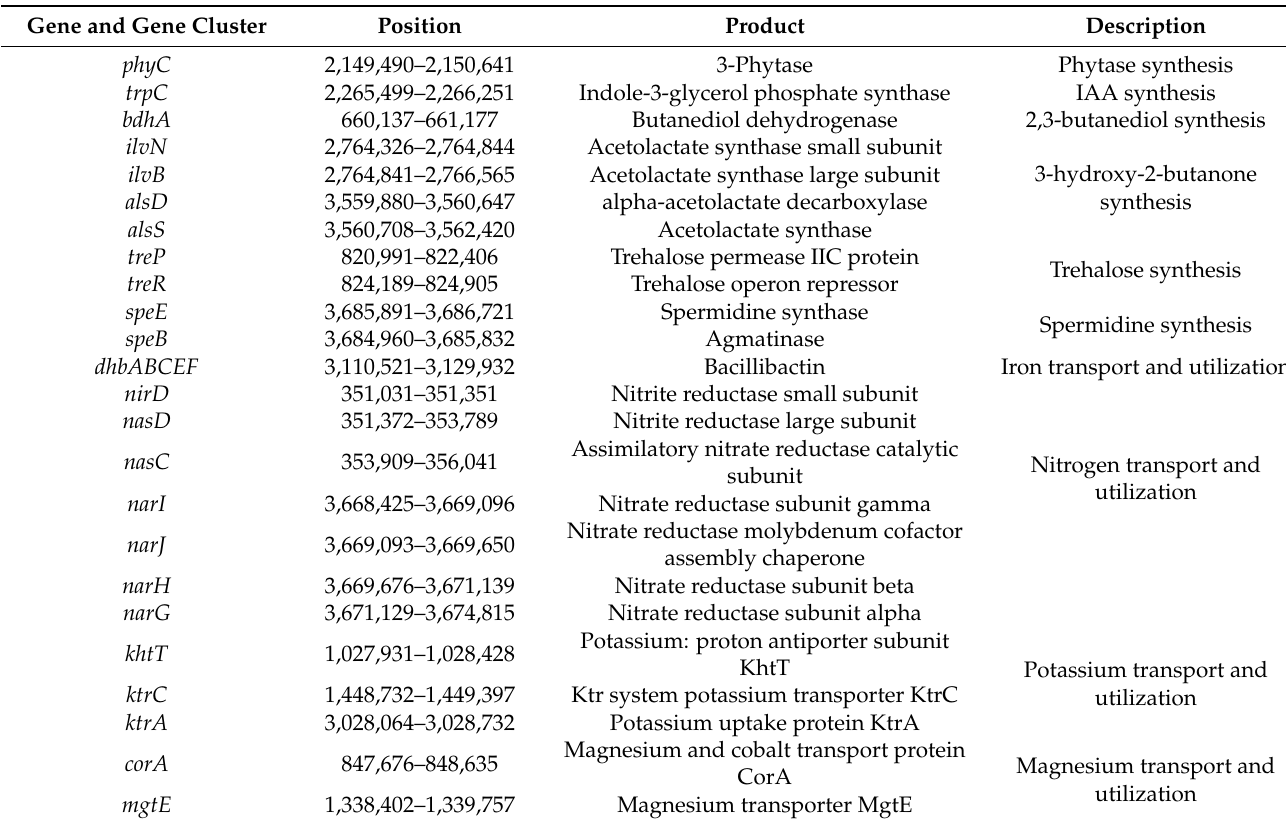
Table 1. Genes related to plant growth promotion in B. velezensis ATR2 genome.